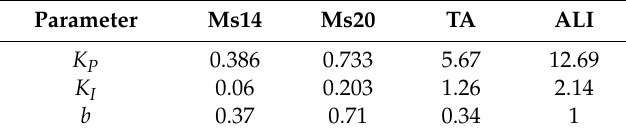
Table 3. PI controller parameters for Case 1.